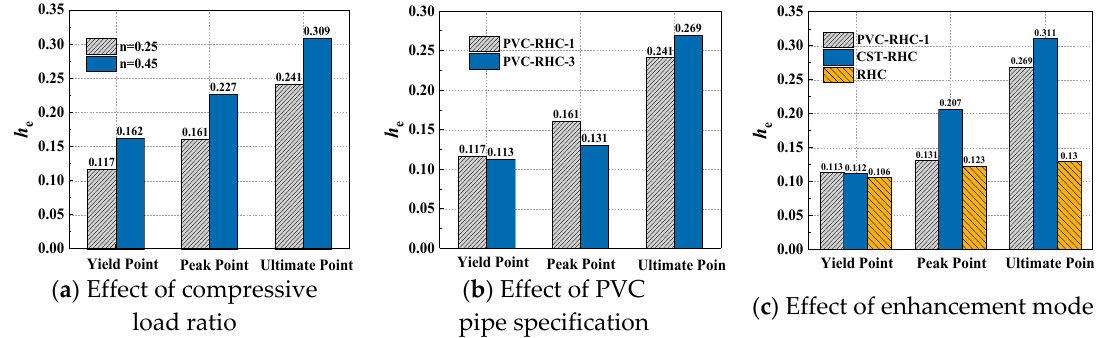
Figure 11. Parametric analysis of the equivalent damping coefficient.